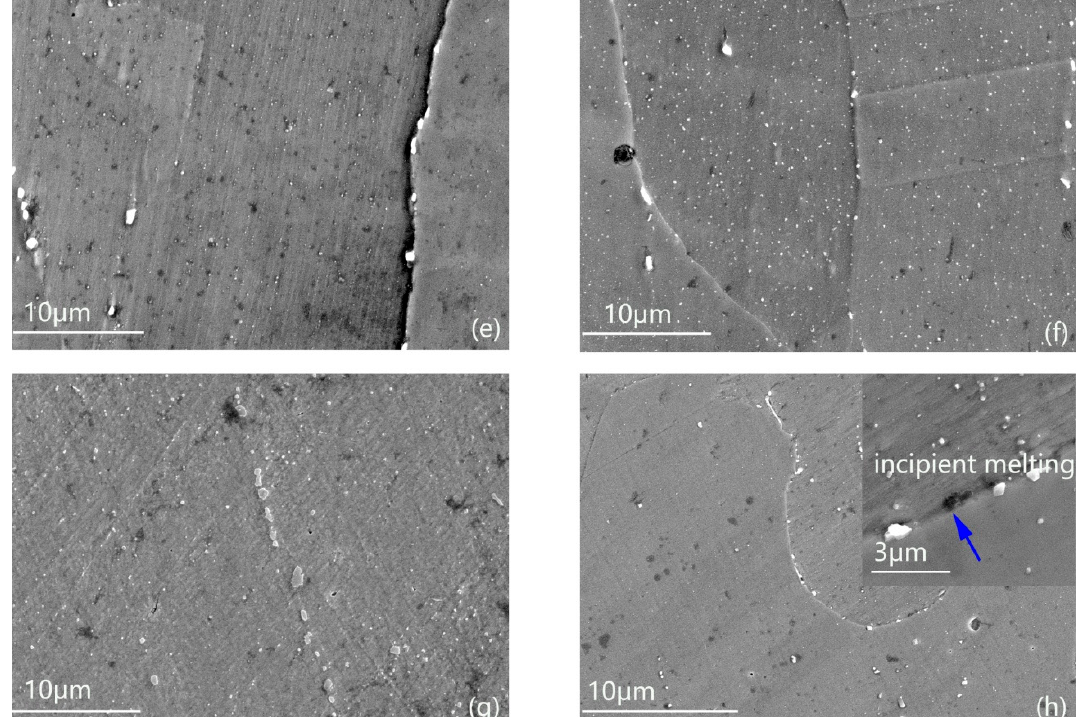
Figure 2. Precipitates distributions of as-deposited sample and solution-treated samples at different temperatures: ( a ) As-deposited, ( b ) 930 °C, ( c ) 980 °C, ( d ) 1030 °C, ( e ) 1080 °C, ( f ) 1130 °C, ( g ) 1180 °C, ( h ) 1230 °C.